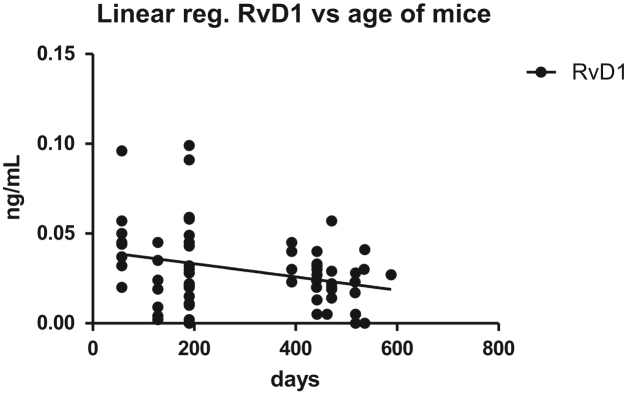
Linear regression of RvD1 versus age of mice s (n = 65, ♀ = 40, ♂= 25, middle age = 291 ± 270 days, R2 = 0.08782, p = 0.0165, slope = −0.00006673 to −0.000006936).